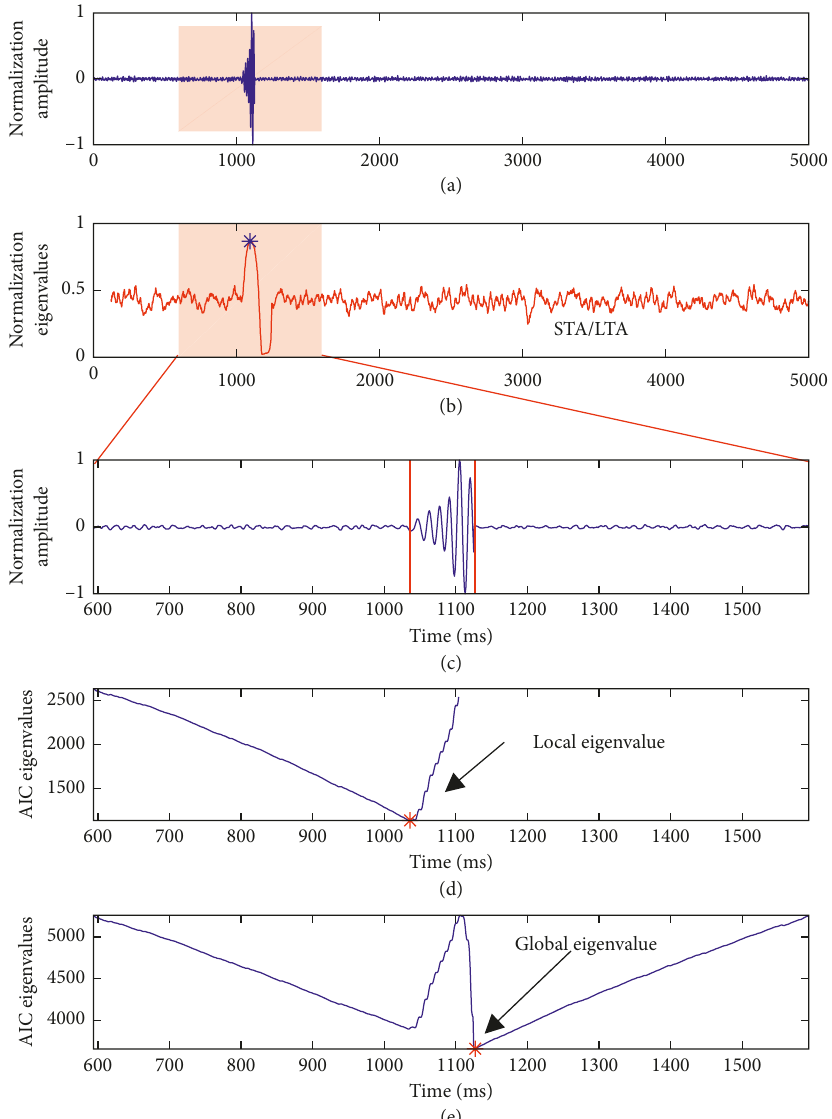
Figure 1: Result of the first arrival picking using the AIC method. (a) A typical MS signal; (b) scaling figure from red part of (a) and two vertical lines show the first arrival time (onset time) and terminal time (offset time); (c) local eigenvalue of AIC method; and (d) global eigenvalue in the whole